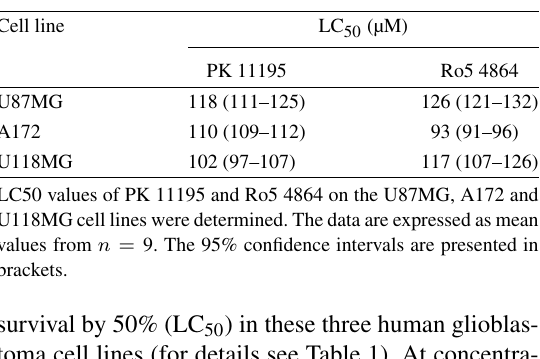
Lethal effects of TSPO ligands on human glioblastoma cell